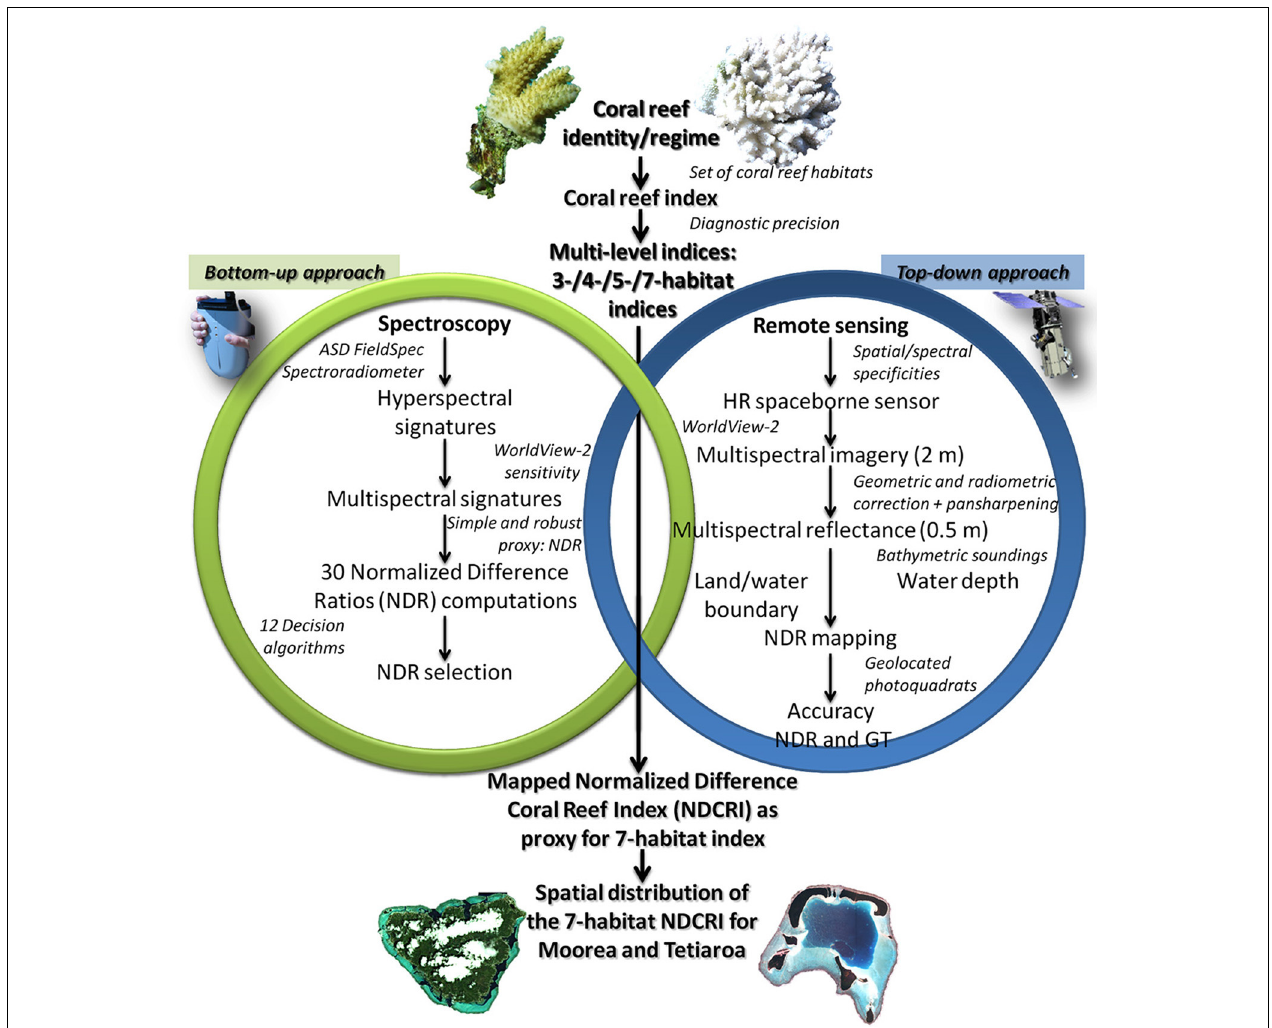
FIGURE 3 | Flowchart of the overarching methodology portraying the necessary steps leading to the spatial model of the Normalized Difference Coral Reef Index ( NDCRI ). The overlapping zone between the